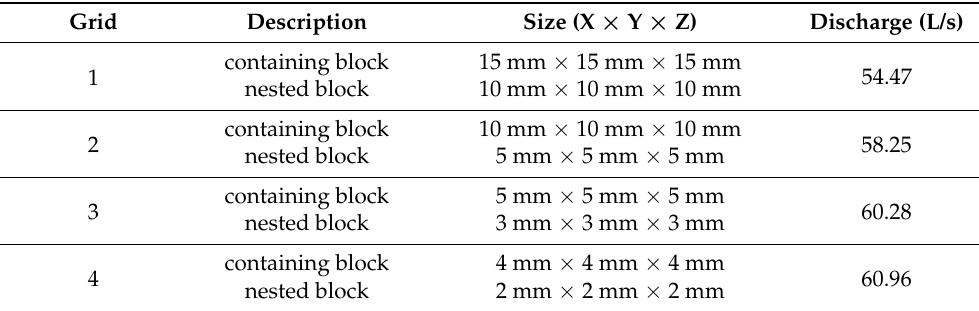
Figure 3. Boundary conditions and grid mesh in the numerical model. Table 1. The results of grid independence (P = 0.1%). Table 1. The results of grid independence (P = 0.1%).